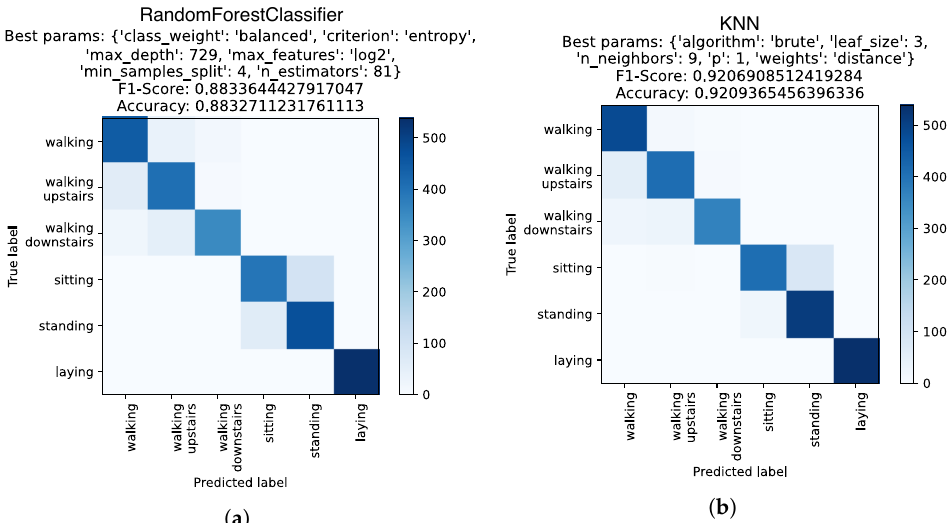
Figure 8. Confusion matrices of the best performing RF and KNN models with its hyperparameters. ( a ) Random Forest. ( b ) KNN.